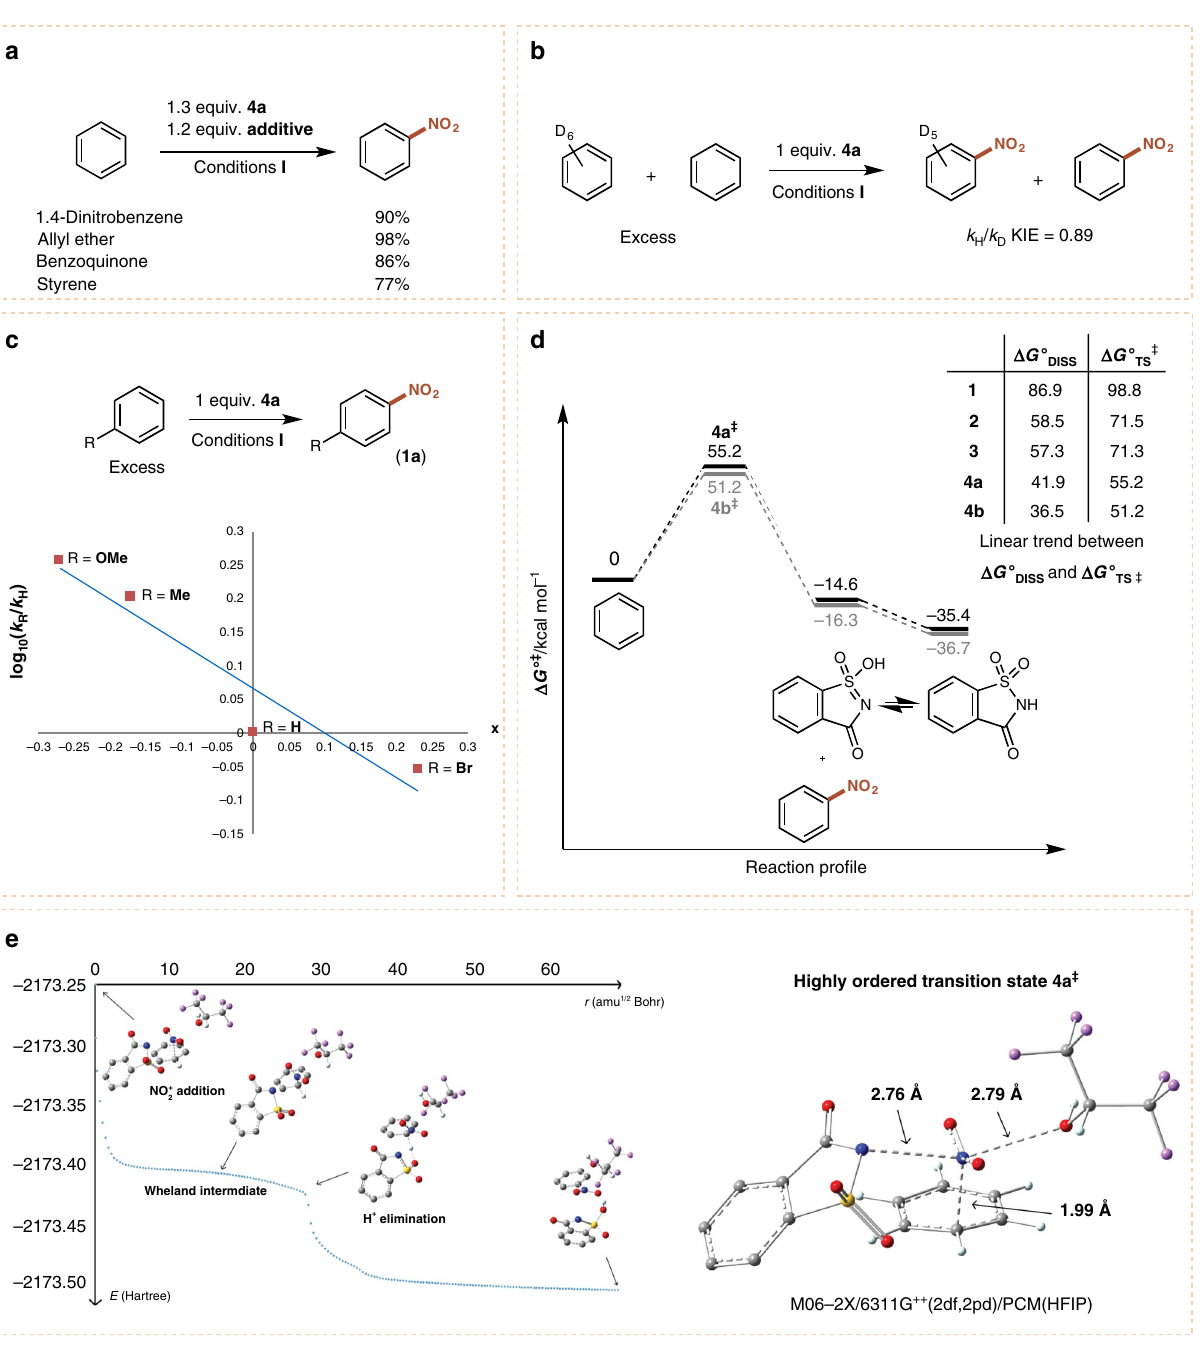
Fig. 4 Mechanistic studies into the nitration of arenes using 4 and procedure I . a Radical trapping experiments. b Kinetic isotope effect by intermolecular competition experiment. c Hammett study. d Gibbs-free energy pro fi le for nitration of benzene using 4a and 4b . e Transition state of nitronium addition to benzene and intrinsic reaction coordinate for nitration of benzene after rate-determining